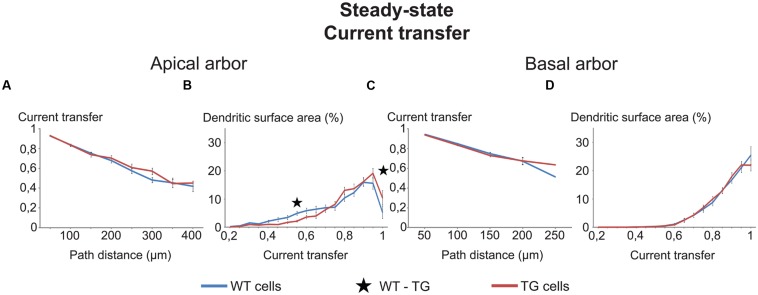
Comparison graphs on currents transfers in WT and TG neurons. Distance dependence of current transfers (A,C) and percentages of total dendritic surface area (B,D) with different rates of current transfers in uniform models of (WT, blue lines) and transgenic (TG, red lines) neurons. Black asterisk marks the only range where TG and WT neurons were different (Mann–Whitney test, p < 0.05). Note that some lines run very close to one another and some parts of lines remain hidden.